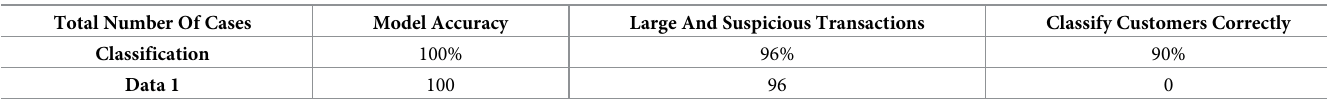
Table 3. Percentage of target classification for each endpoint.